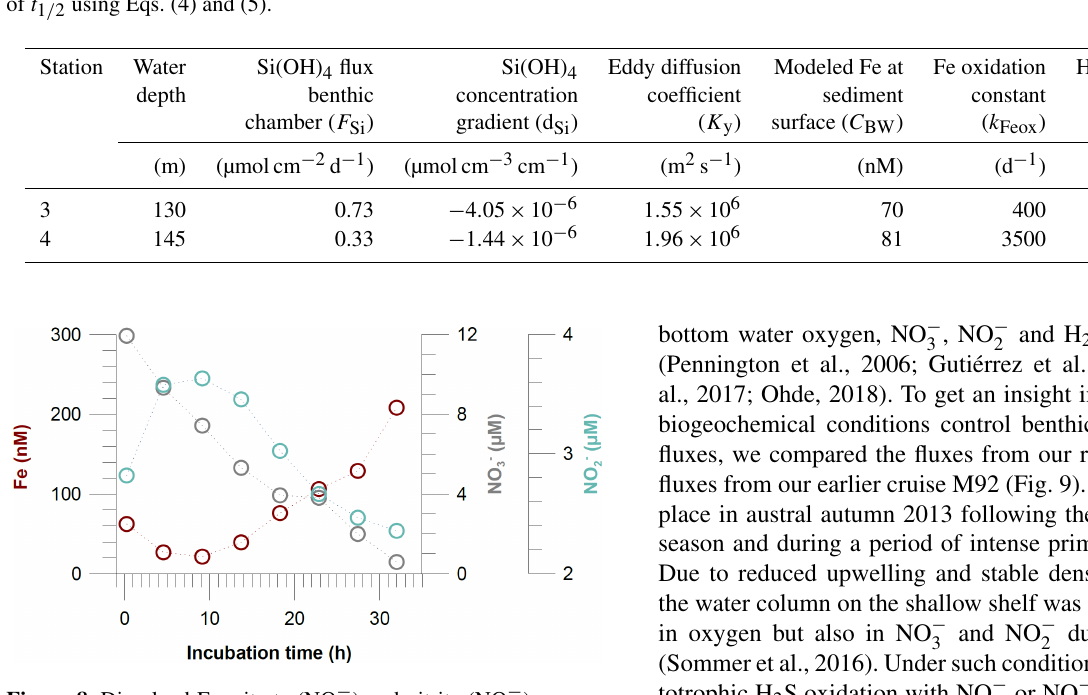
) and nitrite (NO − ) concen- 3 2